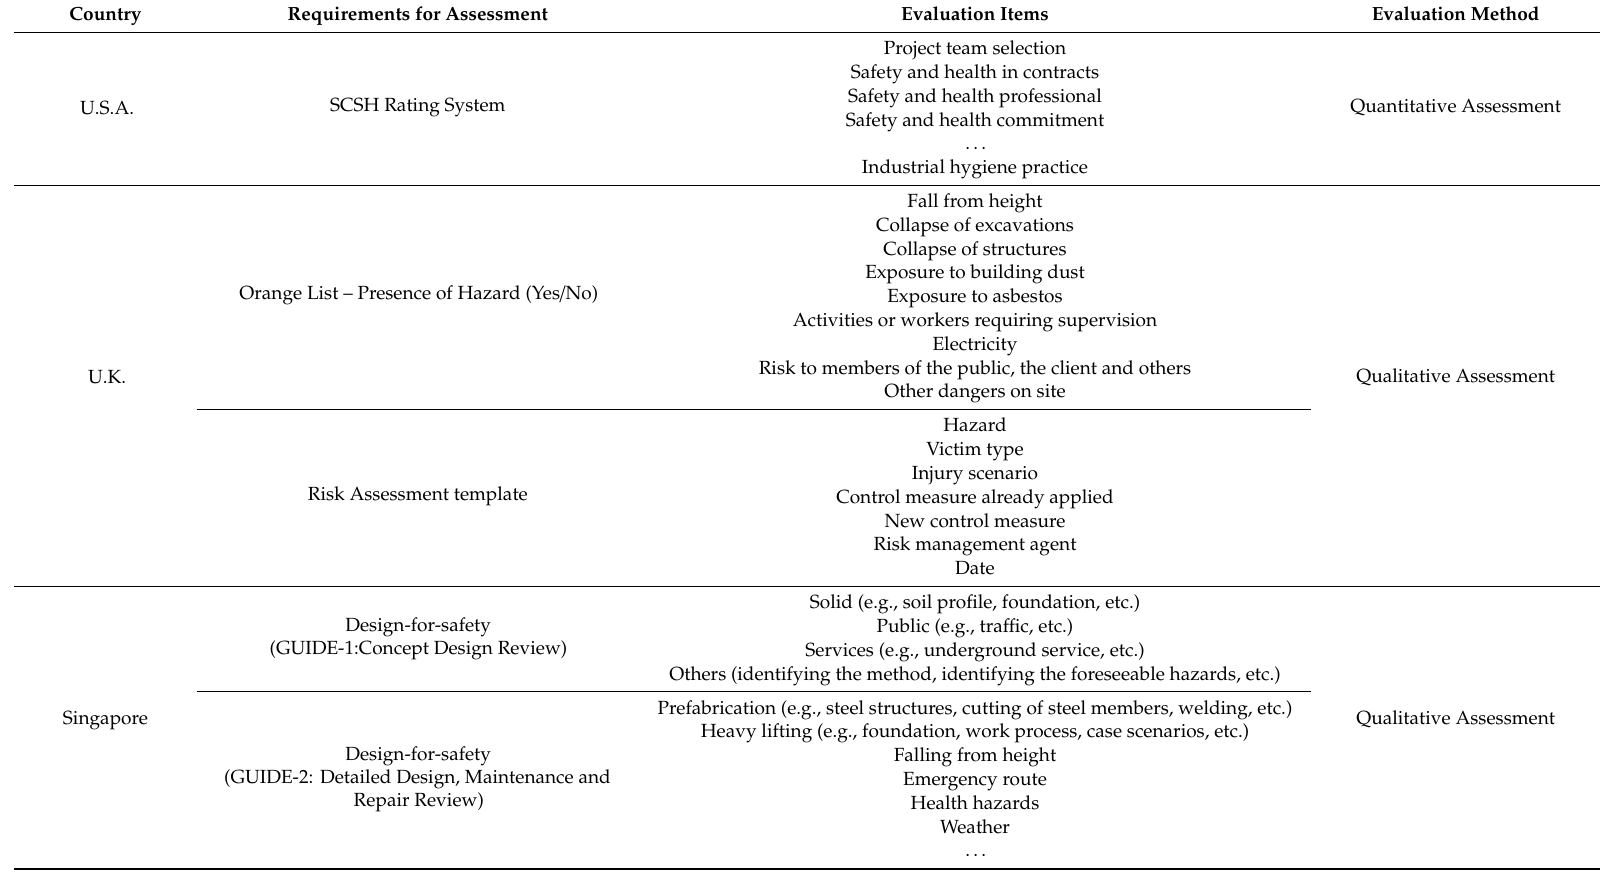
Table 2. Quantitative / qualitative risk assessment classification by